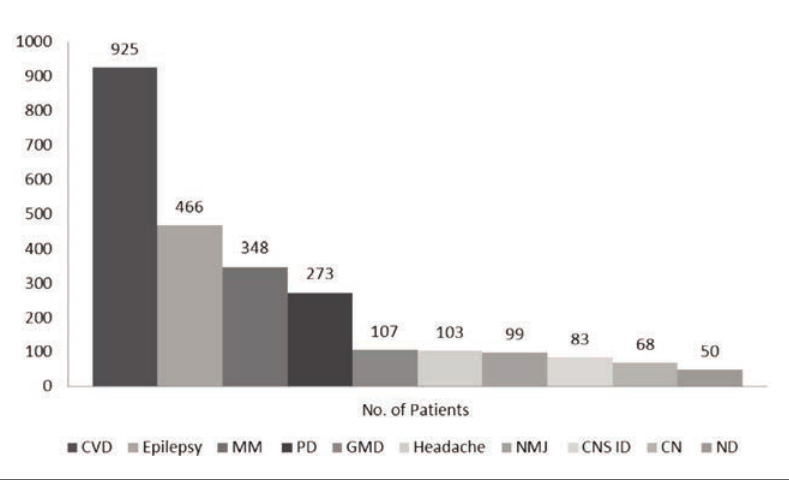
Figure 2. Disease distributions of patients who attended the ambulatory neurology clinic during the study period. CVD, cerebrovascular disease; MM, movement disorders; PD; Parkinson’s disease; GMD, general medical diseases; NMJ, neuromuscular junction; CNS-ID, central nervous system infection; CN, cranial nerve neuropathy; ND, neurode- generative